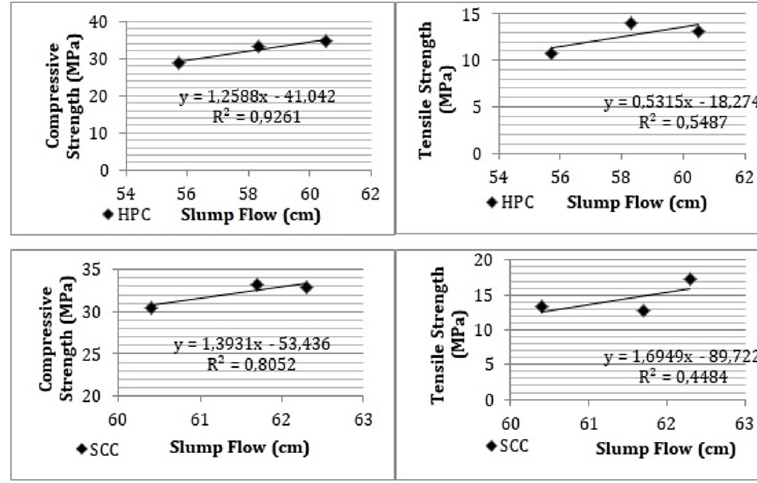
Figure 8. Correlation among slump flow and mechanical strength in HPC and